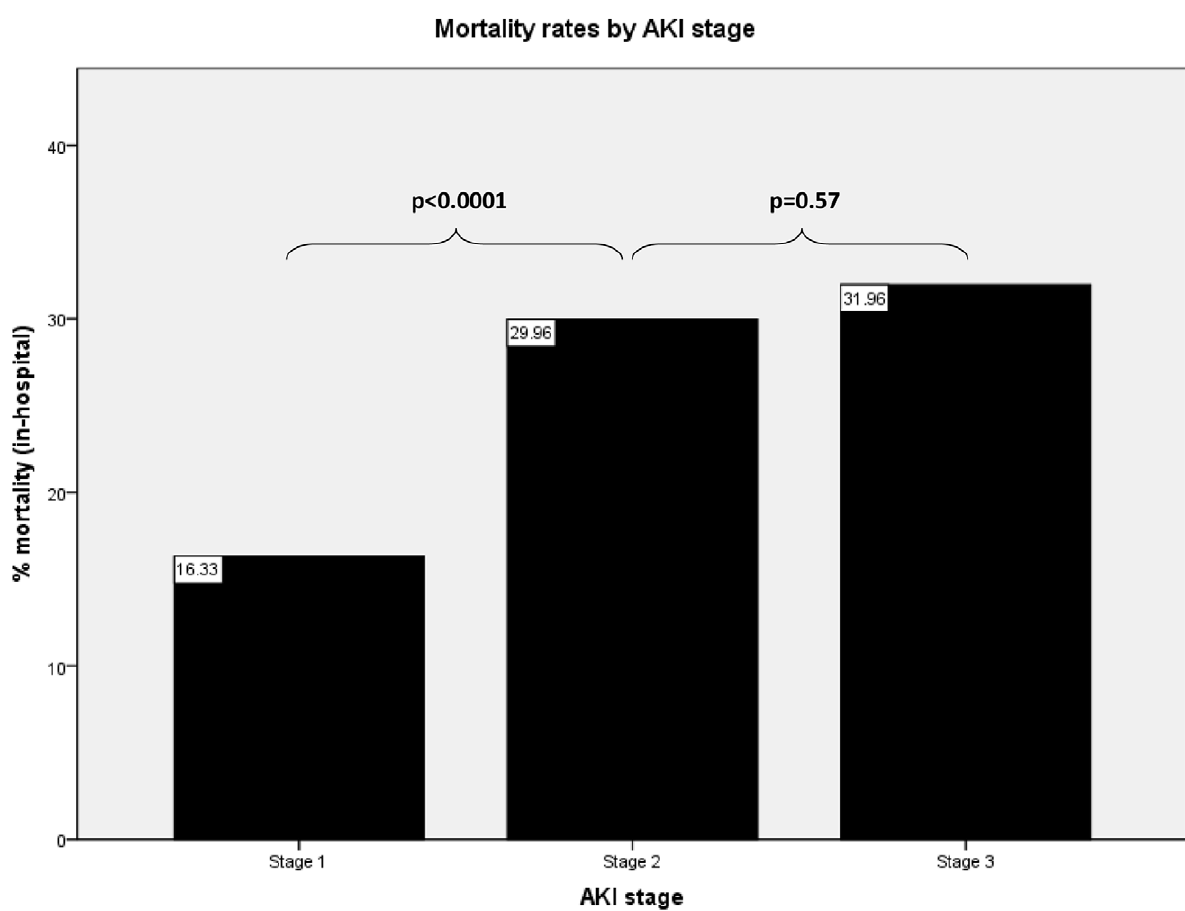
Figure 2. In hospital mortality rates stratified by AKI stage.